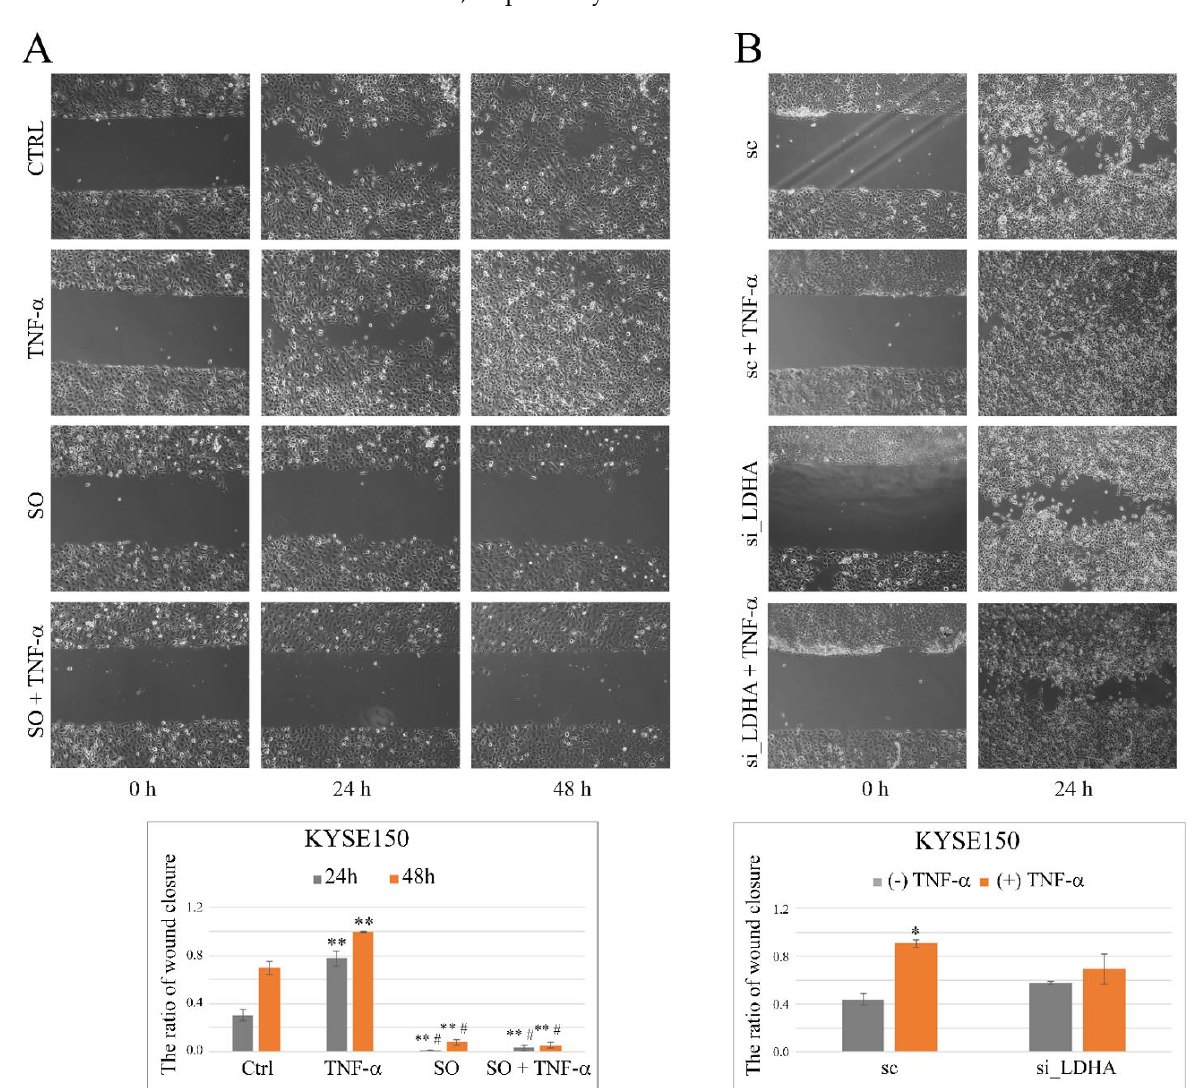
Figure 5. Effect of sodium oxamate and LDHA siRNA on TNF- α -induced migration of esophageal cancer cells. ( A ) Representative images from wound healing assay showing the changes in KYSE150 cell migration under SO and TNF- α applied separately and in combination after 24 h and 48 h of treatment. Quantitative analysis from the wound healing study in the form of a bar graph illustrating the ratio of wound closure in control cells and TNF- α stimulated cells for 24 h and 48 h in the presence of SO and without SO (bottom). ( B ) Representative images from the wound healing assay showing changes in KYSE150 cells with siRNA-mediated silencing of LDHA gene expression and treated with TNF- α for 24 h. Quantitative analysis from the wound healing assay in the form of a bar graph showing the ratio of wound closure after LDHA siRNA (si_LDHA) transfection or scrambled sequence (sc) and 24 h TNF- α stimulation (bottom). Ctrl — control, SO — sodium oxamate, * p < 0.05, ** p < 0.005 (statistical differences vs. controls); # p < 0.005 (statistical differences vs. TNF- α - treated cells).